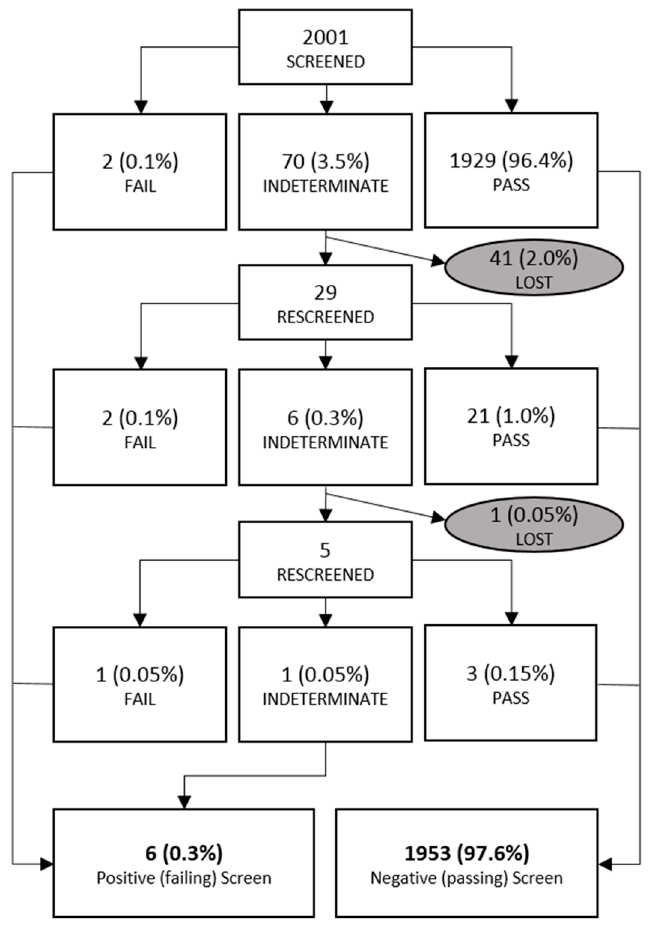
Figure 3. Newborn flow sheet. Demonstration of where newborns were found to pass, fail, or were lost to screening. Percentages listed are relative to the entire study population.